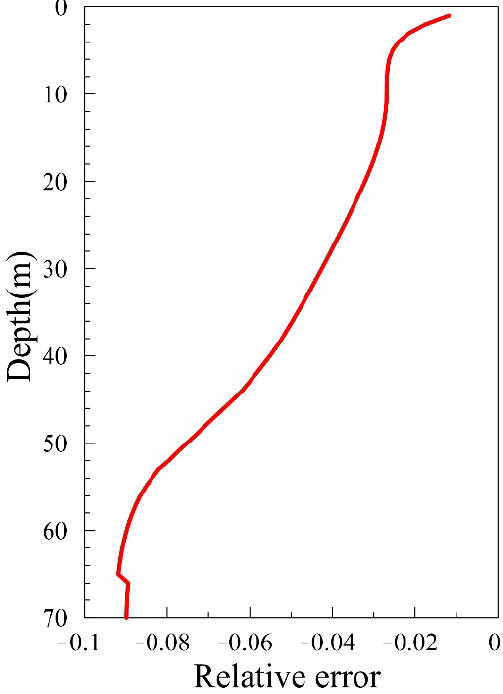
Figure 7. The relative inaccuracy profile of Q/W in the Canada Basin.